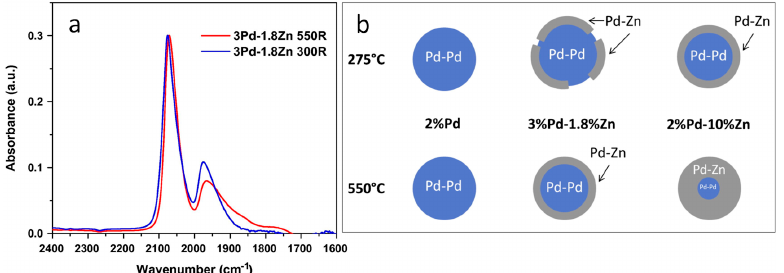
Figure 12. ( a ) Normalized DRIFT spectra of the 3%Pd–1.8%Zn catalyst pre-reduced at 300 °C (red) and at 550 °C (blue). ( b ) Cross-section of Pd and PdZn catalysts showing structure change as reduction temperature increased. Reprinted from J. Catal., 318, D. J. Childers, N. M. Schweitzer, S. Mehdi Kamali Shahari, R. M. Rioux, J. T. Miller, R. J. Meyer, Modifying structure-sensitive reactions by addition of